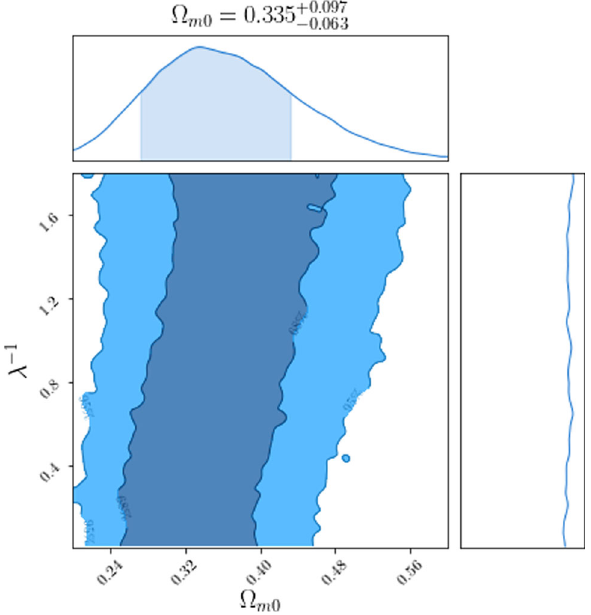
Fig. 5 MCMC simulations for the f ( R ) model with n = 1, consid- ering joint analyses of the H ( z ) and [ f σ 8 ] ( z ) data and the flat priors: λ − 1 = [ 0 . 001 , 2 . 0 ] and Ω = [ 0 . 2 , 0 . 4 ] m 0